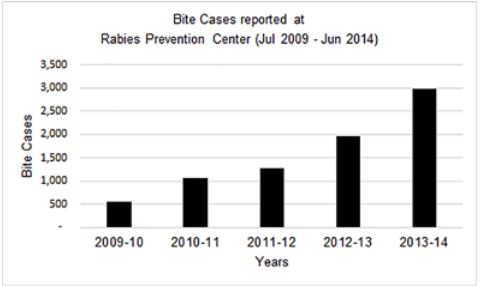
No of patients % n =